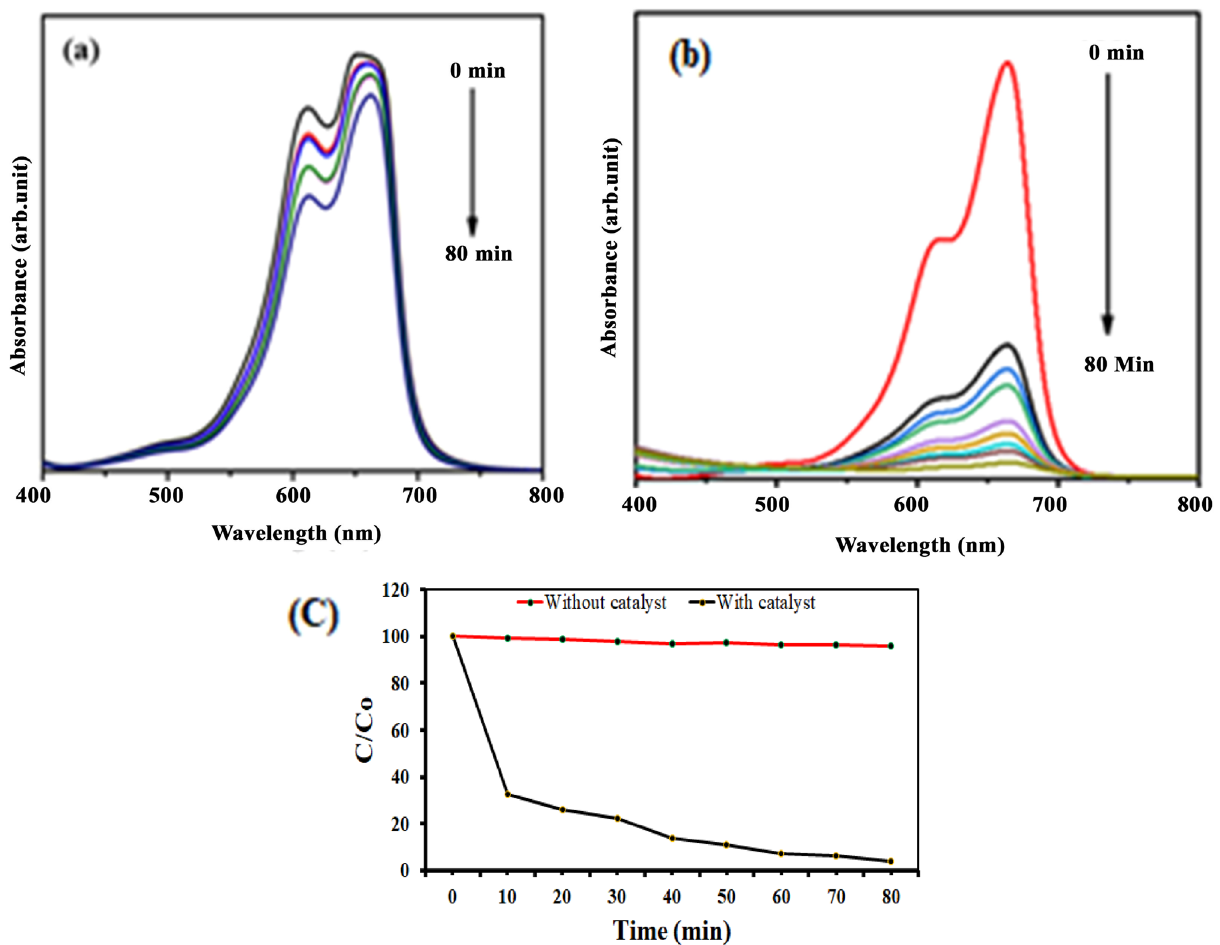
Figure 14. ( a ) Adsorption spectrum of MB under light irritation, ( b ) adsorption spectrum of rapid synthesized SeNPs against MB under light irritation and ( c ) photocatalytic degradation of methylene blue in the presence SeNPs.